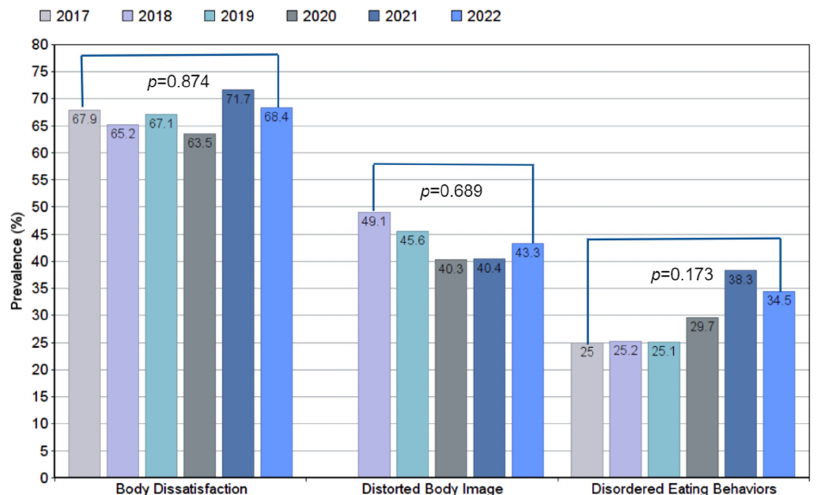
Figure 3. Chi square for trend test. Changes in the prevalence of Body Dissatisfaction, Distorted Body Image and Disordered Eating Behaviors in university students from 2017 to 2022.